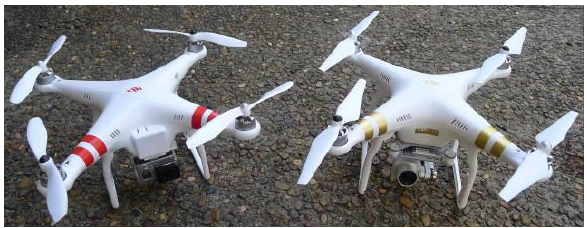
Figure 1. Phantom 1 with GoPro 3+ Black (left) and Phantom 3 Professional with integrated camera and 3-axis gimbal (right).